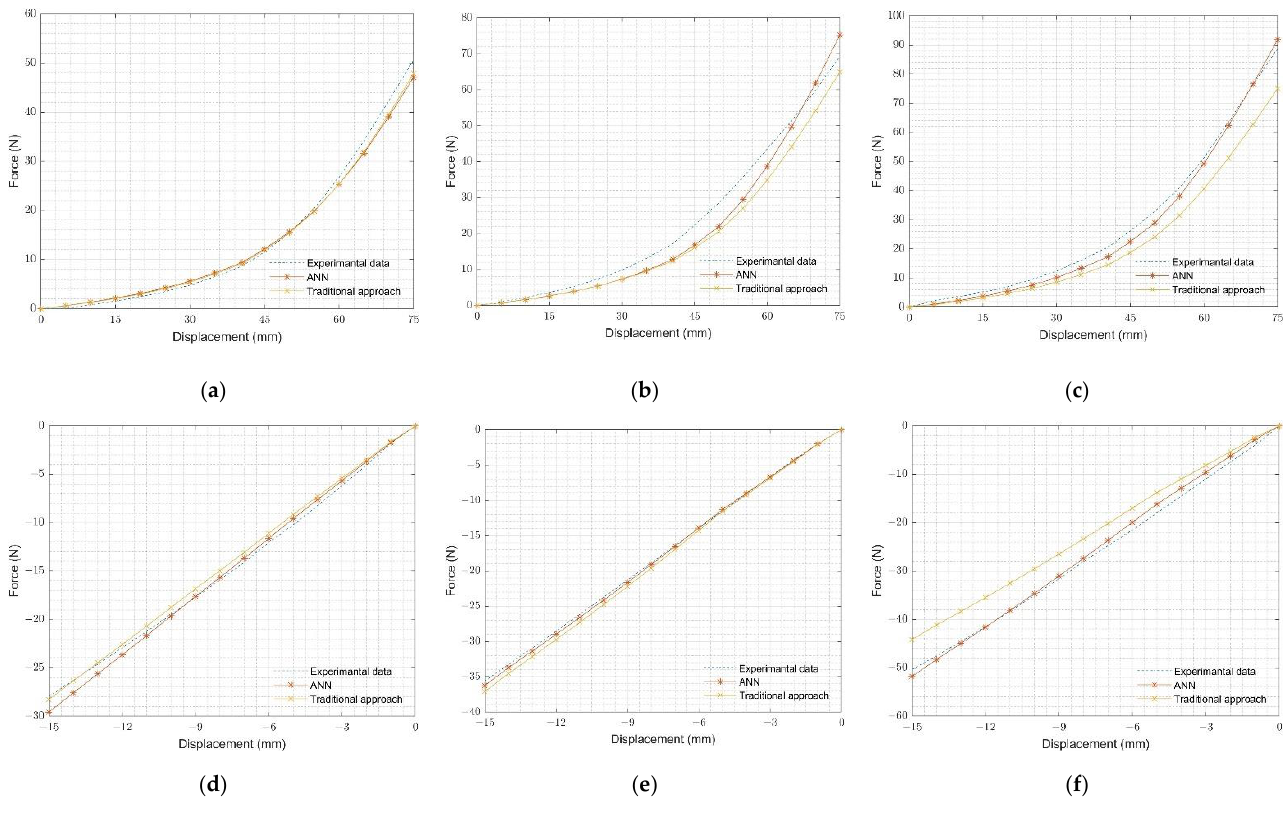
Figure 11. Comparison of experimental and FEA results: ( a ) neoprene rubber O-ring tension test, ( b ) natural rubber O-ring tension test, ( c ) silicone rubber O-ring tension test, ( d ) neoprene rubber O-ring compression test, ( e ) natural rubber O-ring compression test, and ( f ) silicone rubber O-ring compression test.